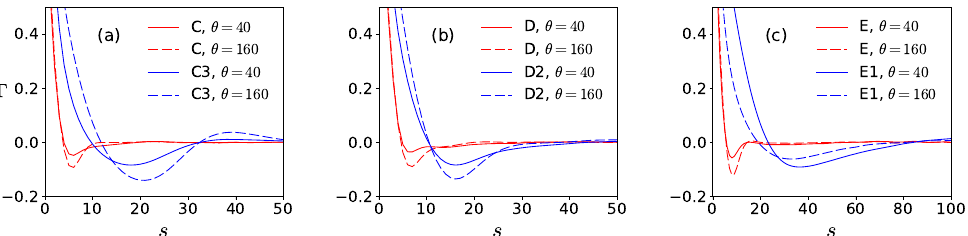
Figure 7. Autocorrelation function of films grown in simulations with ES barriers. All lengths are in units of the lattice